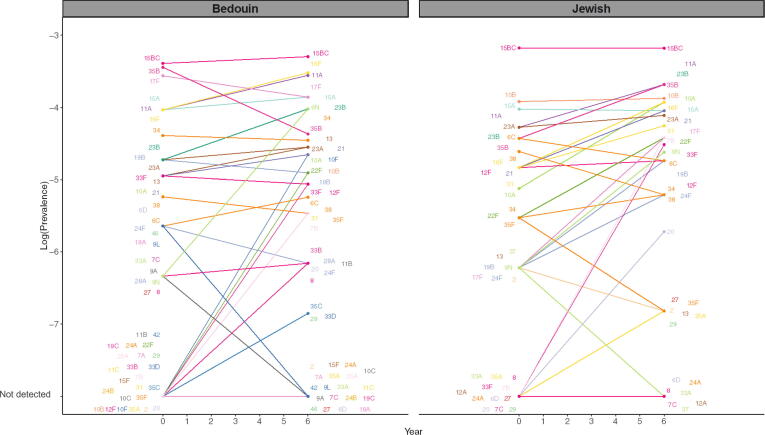
Pre-vaccine vs. post-vaccine pneumococcal prevalence of non-vaccine types for children under 5 in Israel, November 2009-July 2016. The observed log-prevalence of pneumococcus for each serotype is shown at Year 0 and Year 6, separately for Jewish and Bedouin children. If a serotype increased from or decreased to 0, the log prevalence is shown as “not detected” at the bottom of the graph.